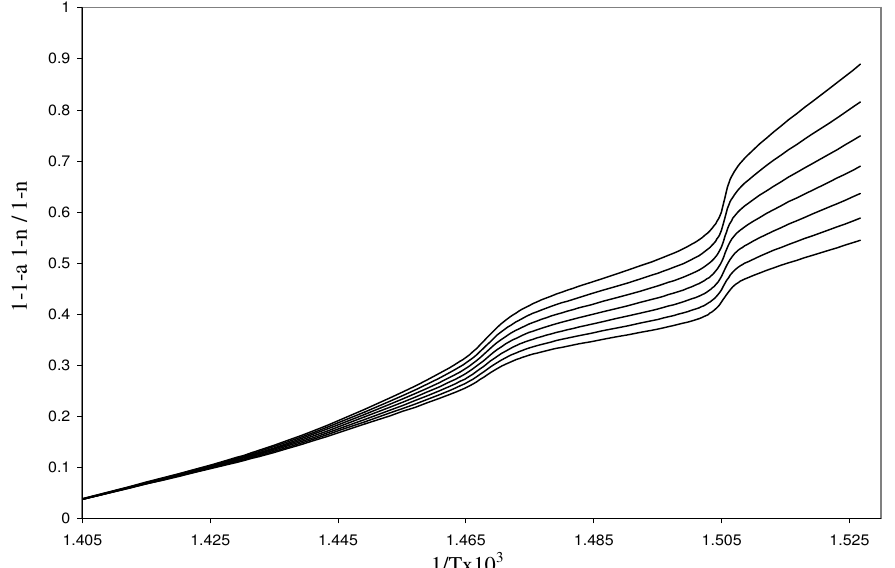
Figure 11. Plot between – log M step II